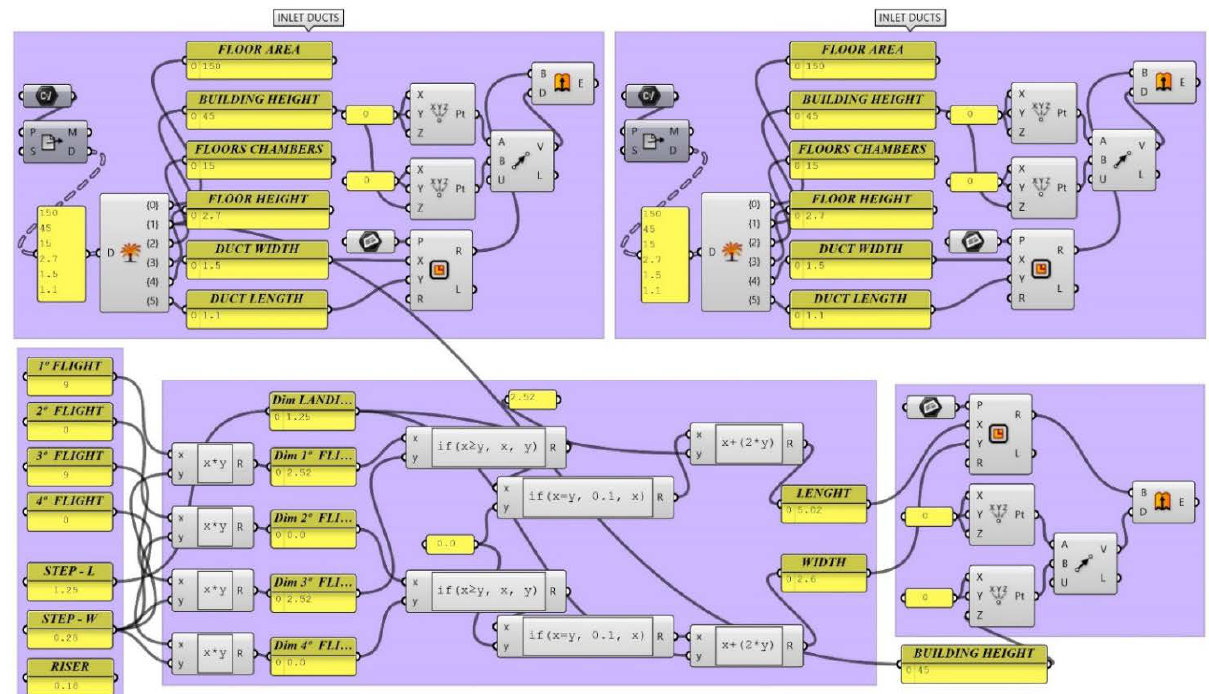
Figure 3. Algorithm used in Grasshopper to create de inlet/outlet ducts and the